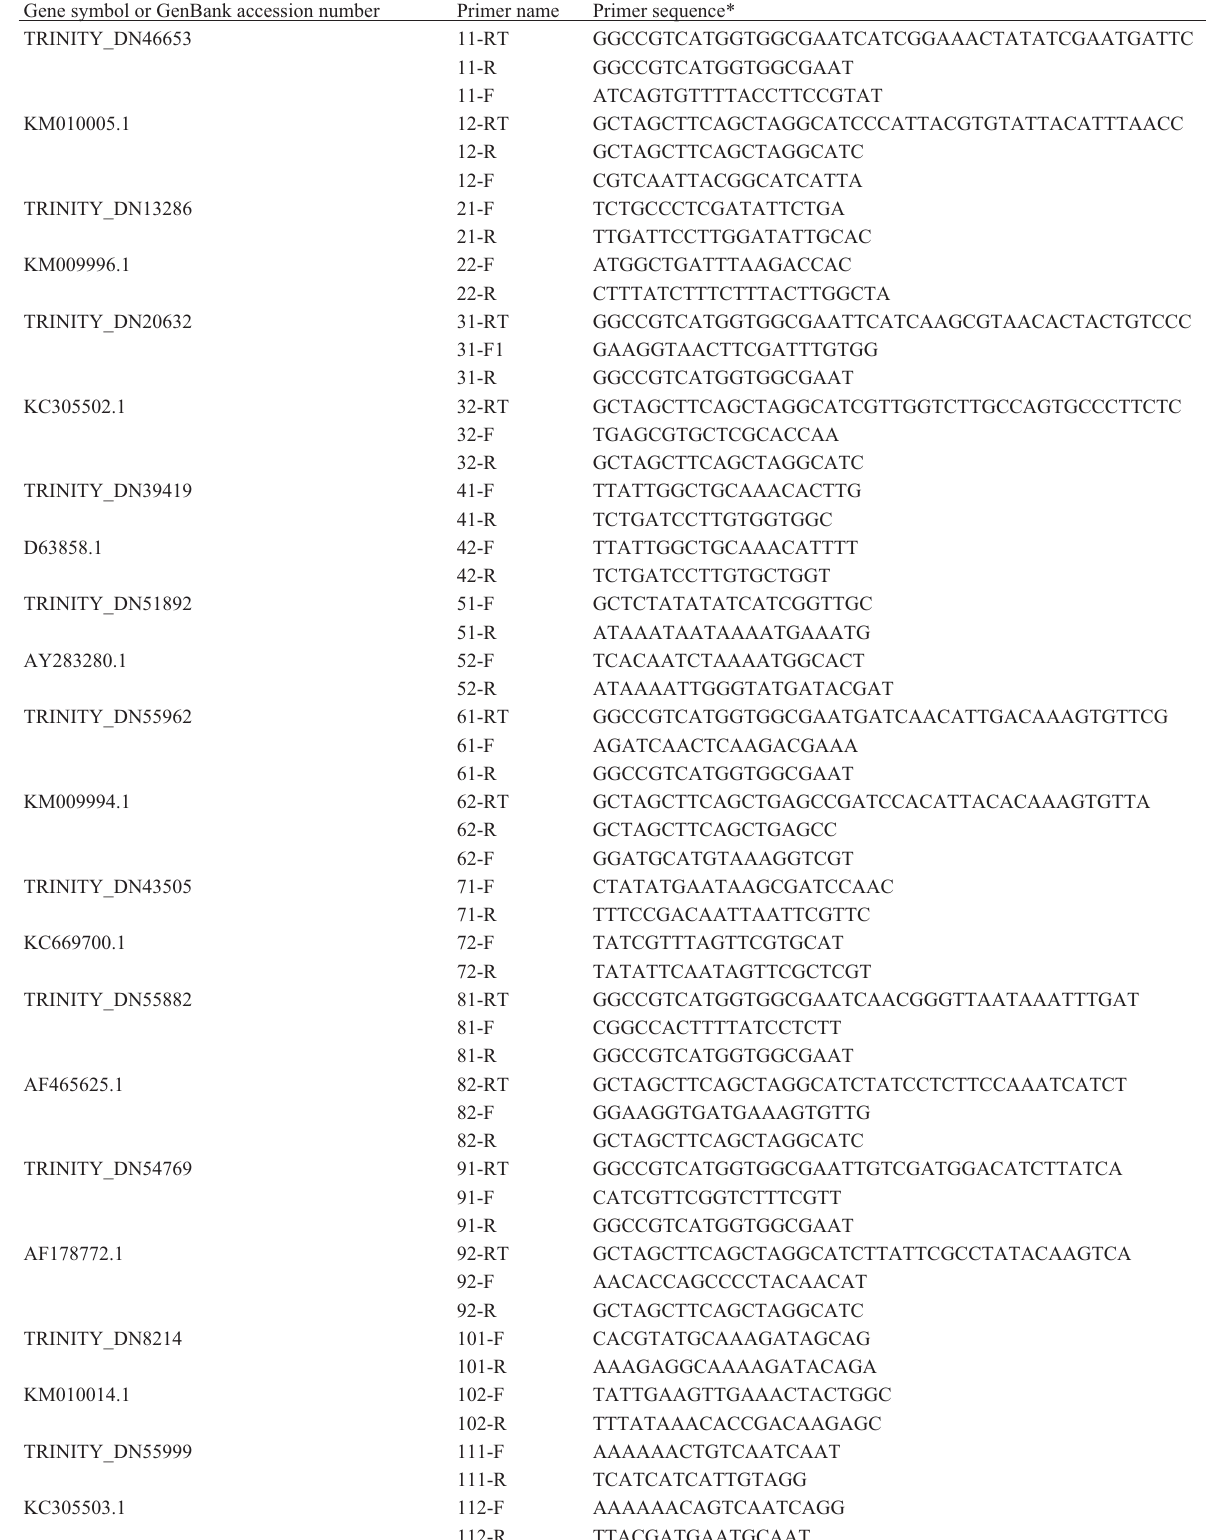
Table 1 - Oligonucleotide sets for strand-specific real-time RT-PCR using tagged primers to quantify lncRNA and targeted mRNA encoding mite aller-